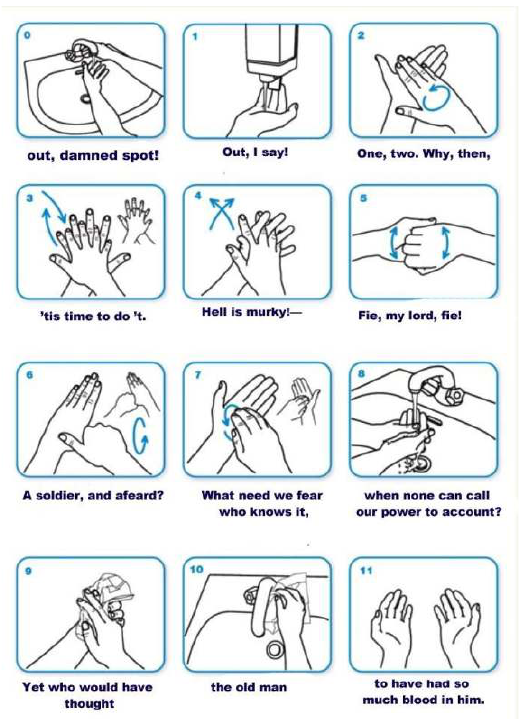
Source: https://www.penguin.co.uk/articles/2020/mar/the-history-behind-the-lady-macbeth-